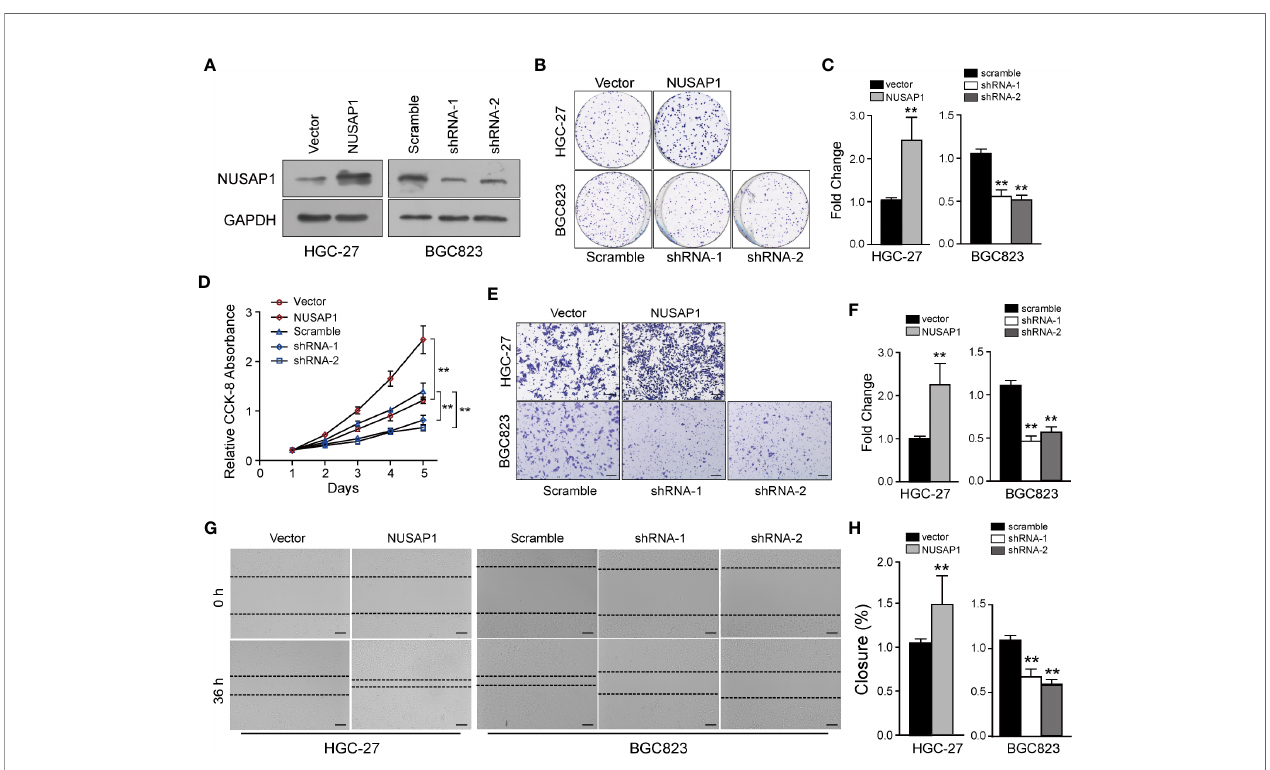
FIGURE 3 | NUSAP1 is required for the proliferation, migration, and invasion of GC cells in vitro . (A) HGC-27 and BGC823 cells were transfected with Flag-NUSAP1 or NUSAP1 shRNAs, and the ef fi ciency was detected by Western blotting. (B, C) Representative images of colony-formation assays for modi fi ed HGC-27 and BGC823 cells. Cells were fi xed and stained, the colonies were counted, and the data are represented in the bar graph. (D) Cell viability was analyzed by CCK-8 assay. (E, F) Representative images of fi xed and stained modi fi ed HGC-27 and BGC823 cells in the Transwell invasion assays (magni fi cation, ×200). (G, H) Cell migration ability evaluated by wound-healing assays (magni fi cation, ×100). Student ’ s t test: ** p